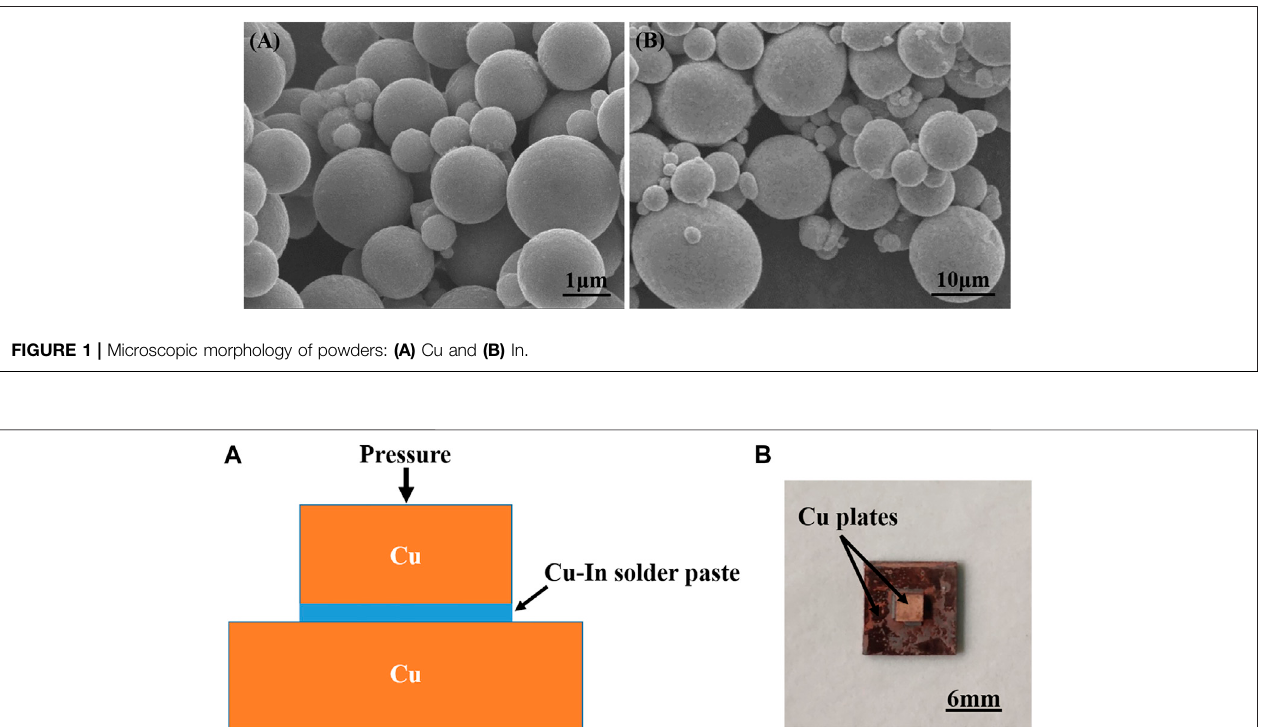
Frontiers in Materials |